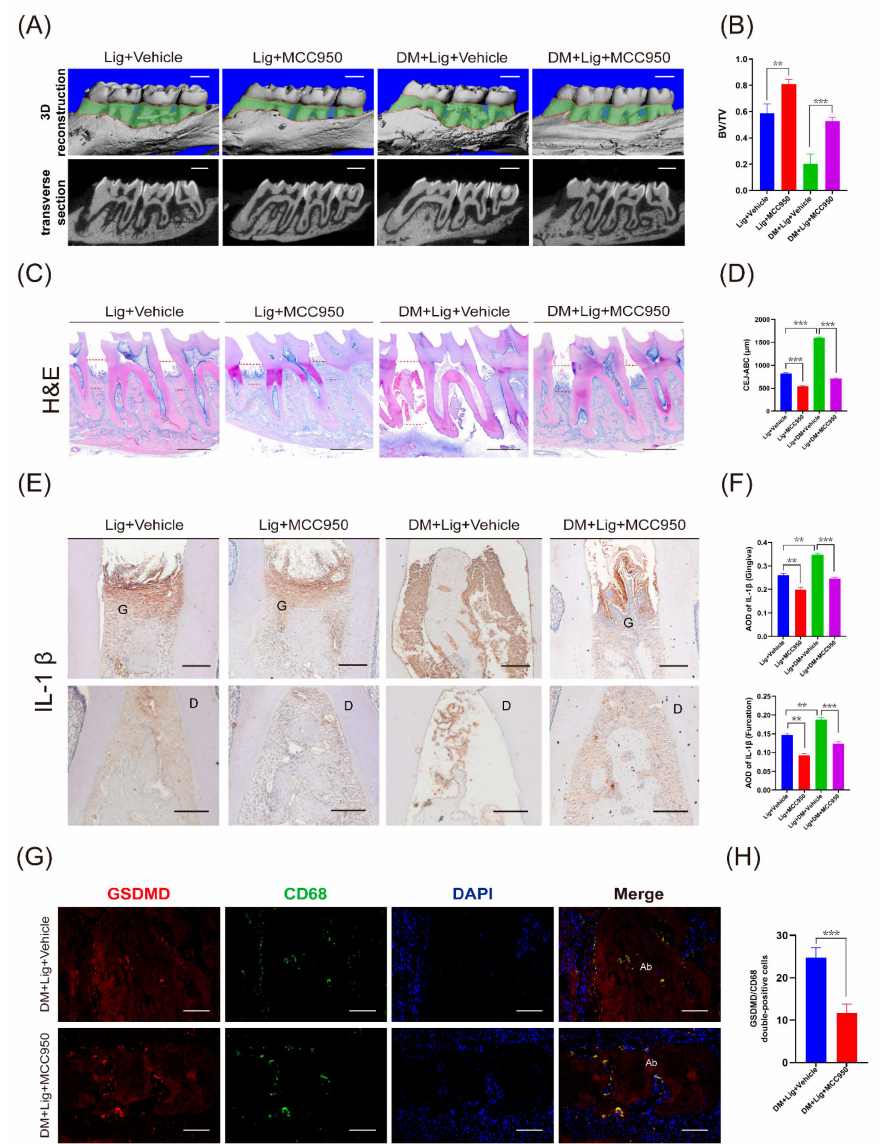
Figure 2. MCC950 rescued the bone loss of diabetes mellitus–periodontitis in rats. ( A ) Representative 3D reconstructions and X-ray photos of the Lig + Vehicle, Lig + MCC950, DM + Lig + Vehicle, and DM + Lig + MCC950 groups. The green area displays the exposure of the root (scale bar: 1 mm). ( B ) BV/TV of the above 4 groups was measured. ( C ) Representative images of HE staining (scale bar: 1 mm). ( D ) Distances between the CEJ and the ABC. ( E ) Immunohistochemistry staining against IL-1 β of periodontal tissues (Scale bar: 200 µ m). ( F ) Quantitative analysis of IL-1 β in the gingiva and the furcation of the second molar. ( G ) Representative images of immunofluorescence staining of CD68 and GSDMD in the periodontium of the DM + Lig + Vehicle and DM + Lig + MCC950 groups. Nuclei were stained with DAPI (blue). Scale bar, 100 µ m. ( H ) The number of GSDMD/CD68 double-stained cells was analyzed. Data in ( B , D , F , H ) are shown as mean ± SD ( n = 4). ** p < 0.01. *** p < 0.001. G, gingiva; D, dentin; Ab, alveolar bone; CEJ-ABC, cementoenamel junction and alveolar bone crest; AOD, average optical